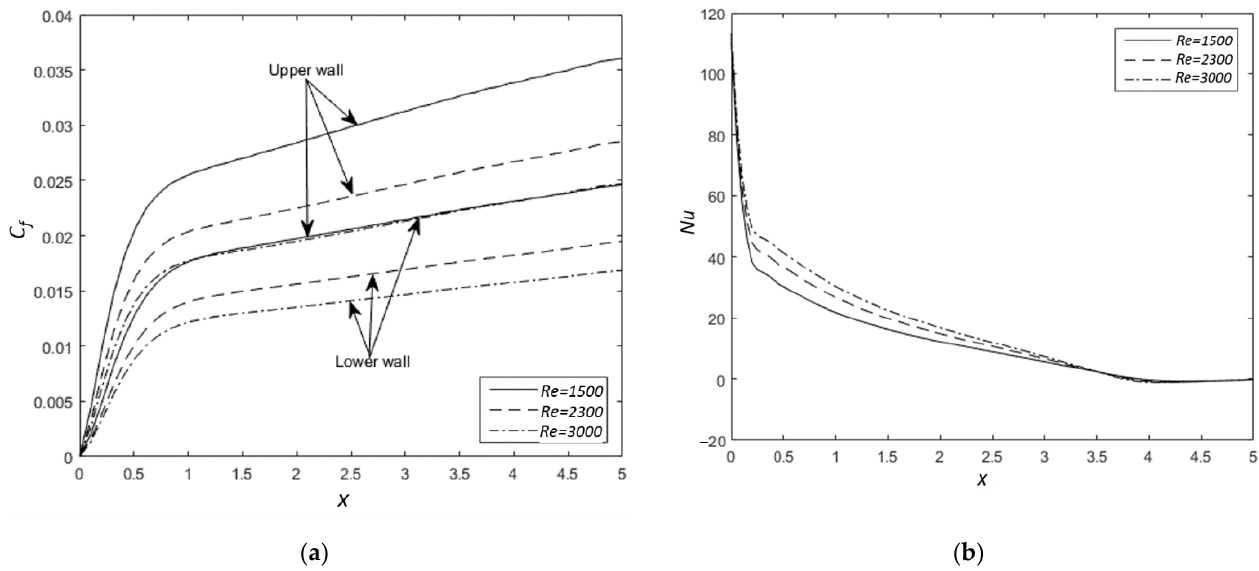
Figure 9. Wall Skin Coefficient and Nusselt number under different Reynold numbers: ( a ) Skin friction coefficient; ( b ) Nusselt number.